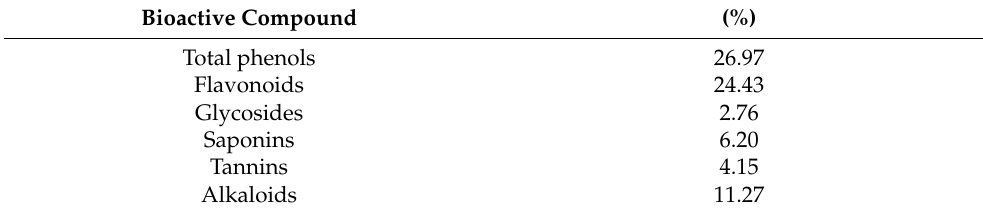
Table 3. Bioactive compounds in powdered rocket salad